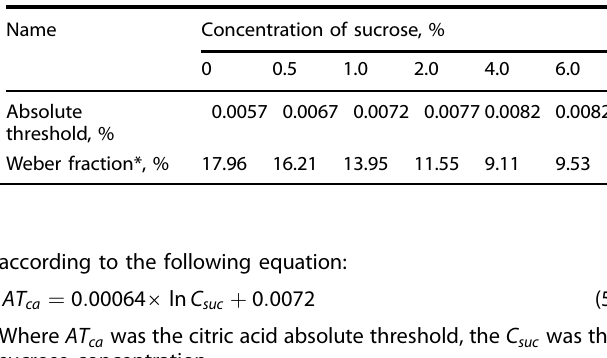
Fig. 2 Citric acid taste sensation curves in different concentration of sucrose solutions. a Showed the sour sensory difference strength of citric acid; b showed the relationship between citric acid absolute threshold value and sucrose concentration; c showed the relationship between citric acid Weber fraction and sucrose concentration. Table 2. The absolute threshold values and Weber fraction of citric acid in different concentrations of sucrose